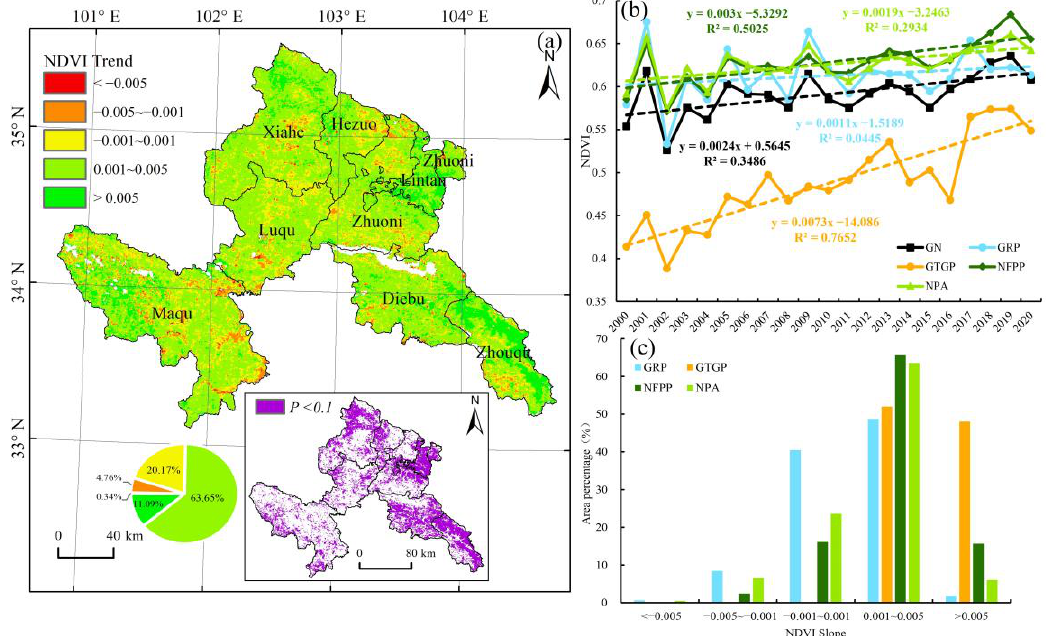
Figure 2. ( a ) Spatial distribution and significance test results of normalized difference vegetation index (NDVI) variation trends in Gannan Prefecture during 2000 – 2020. ( b ) Inter-annual changes in NDVI in different regions. ( c ) Proportion of different NDVI slopes in various ecological protection and restoration projects, including the Grassland Restoration Project (GRP), Grain to Green Project (GTGP), Natural Forest Protection Project (NFPP), and Natural Protection Areas (NPA).